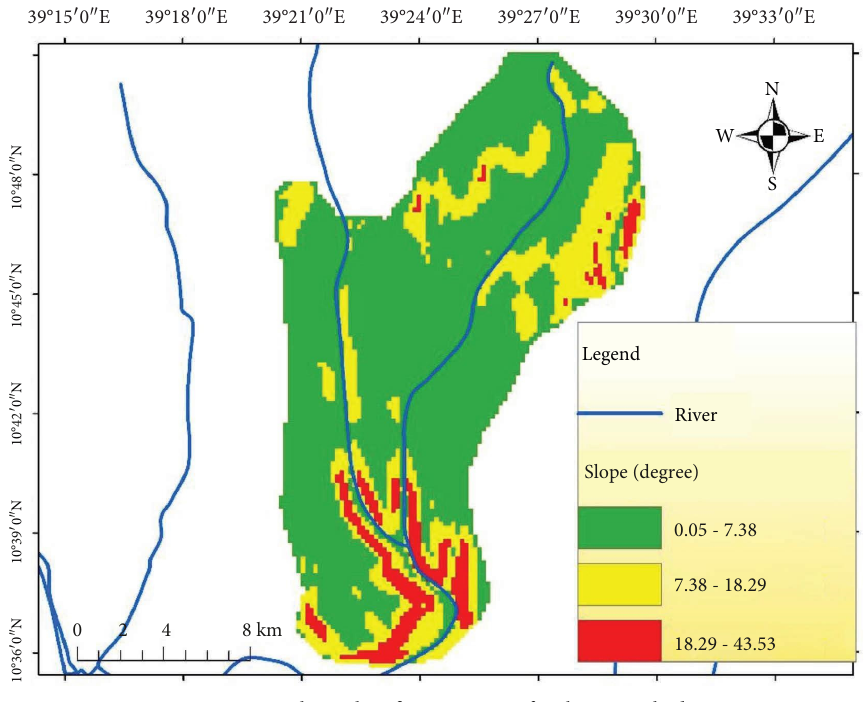
Figure 10: Slope classifcation map of Kabe watershed.